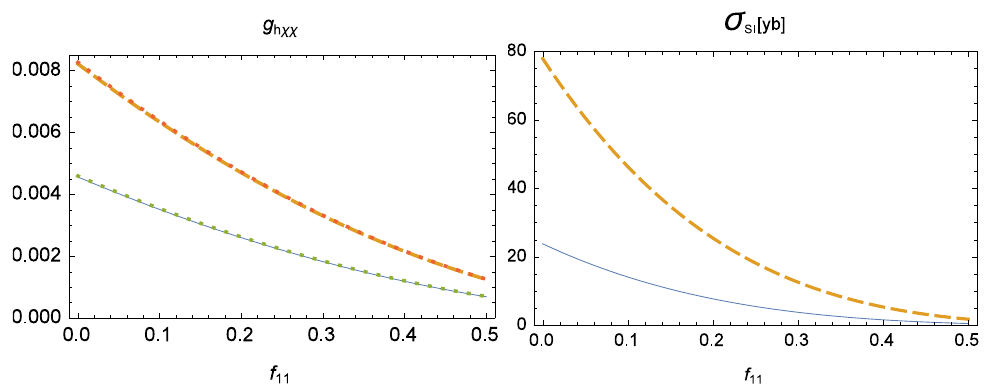
Figure 2. ( Left ) The coupling g h χχ and ( Right ) the cross-section σ SI as a function of f 11 for ˜ f = − 0.41, tan β = 2, (cid:101) µ = 2TeV, µ = 200GeV (solid lines) and µ 11 1 11 dotted lines correspond to the approximate expression for g h χχ (33).